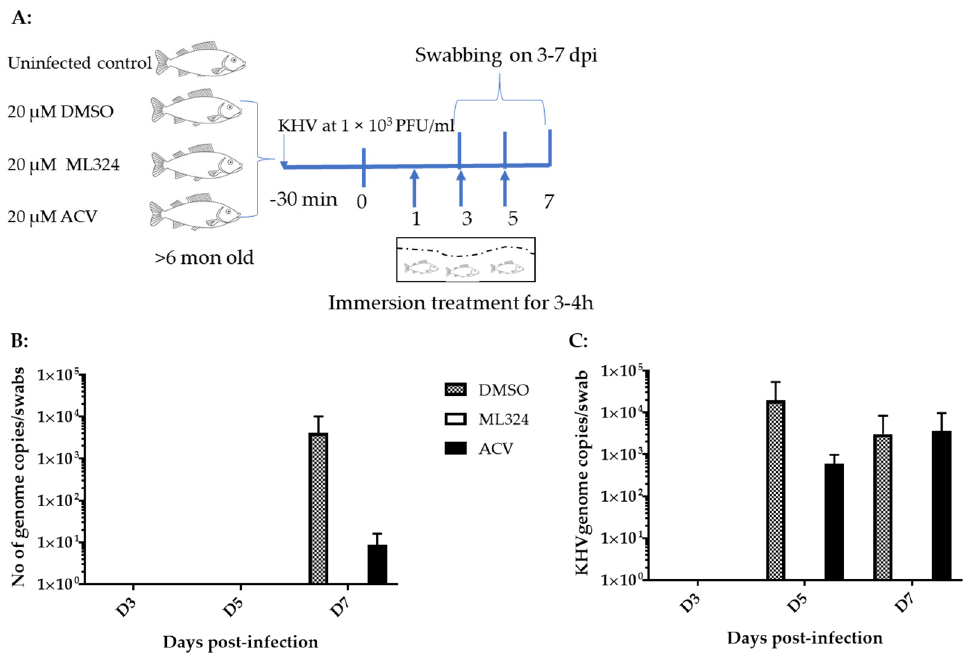
Figure 4. Schematic of the experimental protocol and CyHV-3 genome copy numbers in koi gill and vent swabs. ( A ) Before the immersion treatment, koi were infected via immersion bath containing 1 × 10 3 PFU CyHV-3-U per ml for 30 min. Four groups of koi at 15 koi per group, at about six months to 1-year-old, were kept separately in a 3 ft tank with flow through water maintained at 15 ° C. The treatments were given on days 1, 3, and 5 post-infection via immersion bath containing 20 µM ML324, ACV, or dilution media DMSO, respectively. The number represents the average CyHV-3 DNA copy number estimated by real-time PCR [8] in three gills ( B ) or three vents ( C ) swabs collected on days 3, 5, and 7 post-infection. Koi were infected with CyHV-3, as described in ( A ). Infected koi were immersed in 5 L of water containing 2 mL of DMSO, 2 mL of 50 mM ACV diluted in DMSO (20 µ M in immersion bath), or 2 mL of 50 mM ML324 diluted in DMSO on days 1, 3, and 5 post-infection for 3–4